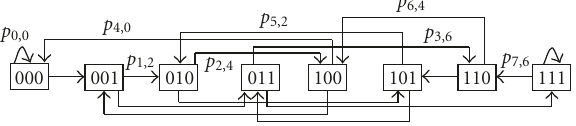
Figure 2: A 3-rd Order Markov